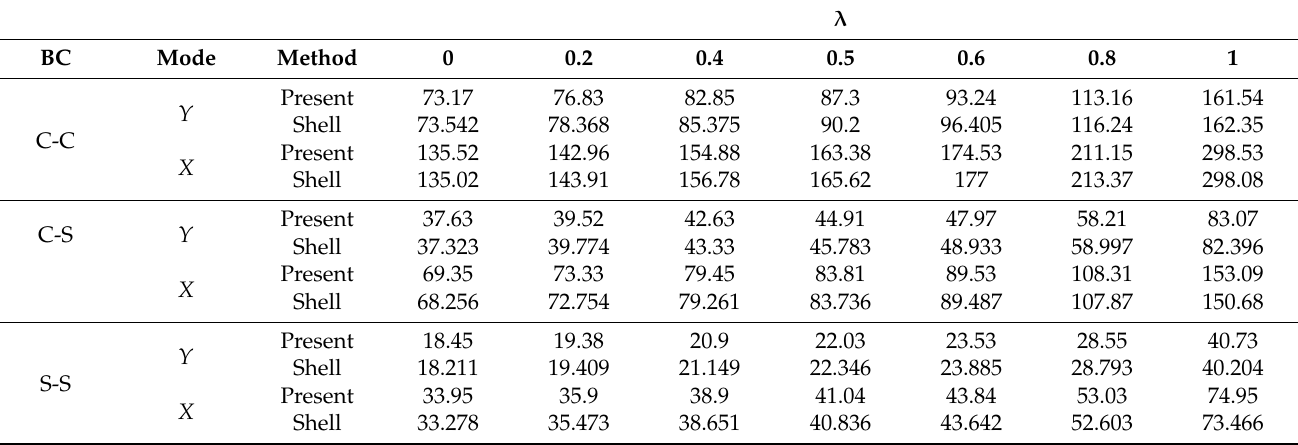
Table 3. Critical buckling temperatures of the beam L 2 = 8 m for different boundary conditions and material thickness ratios.